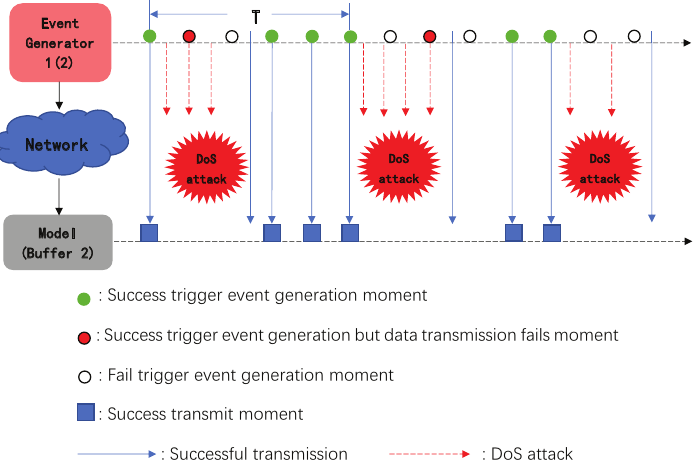
Figure 2. Diagram of information transmission under DoS attacks.